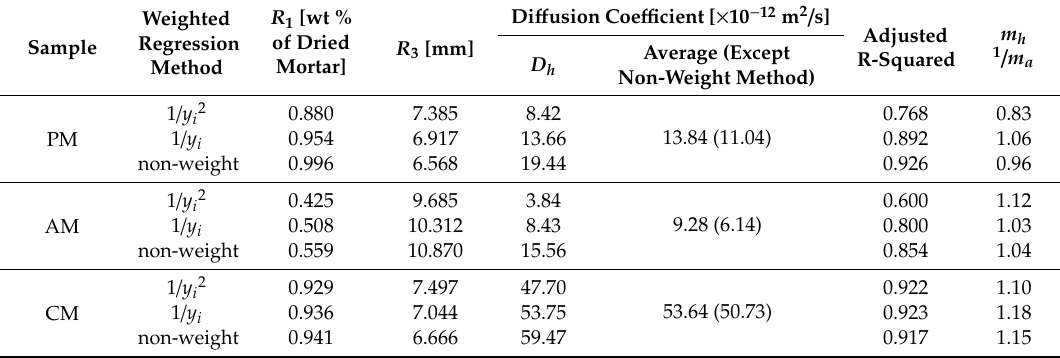
Table 9. Computed parameters of fitted curve using Holliday equation in the natural chloride di ff usion